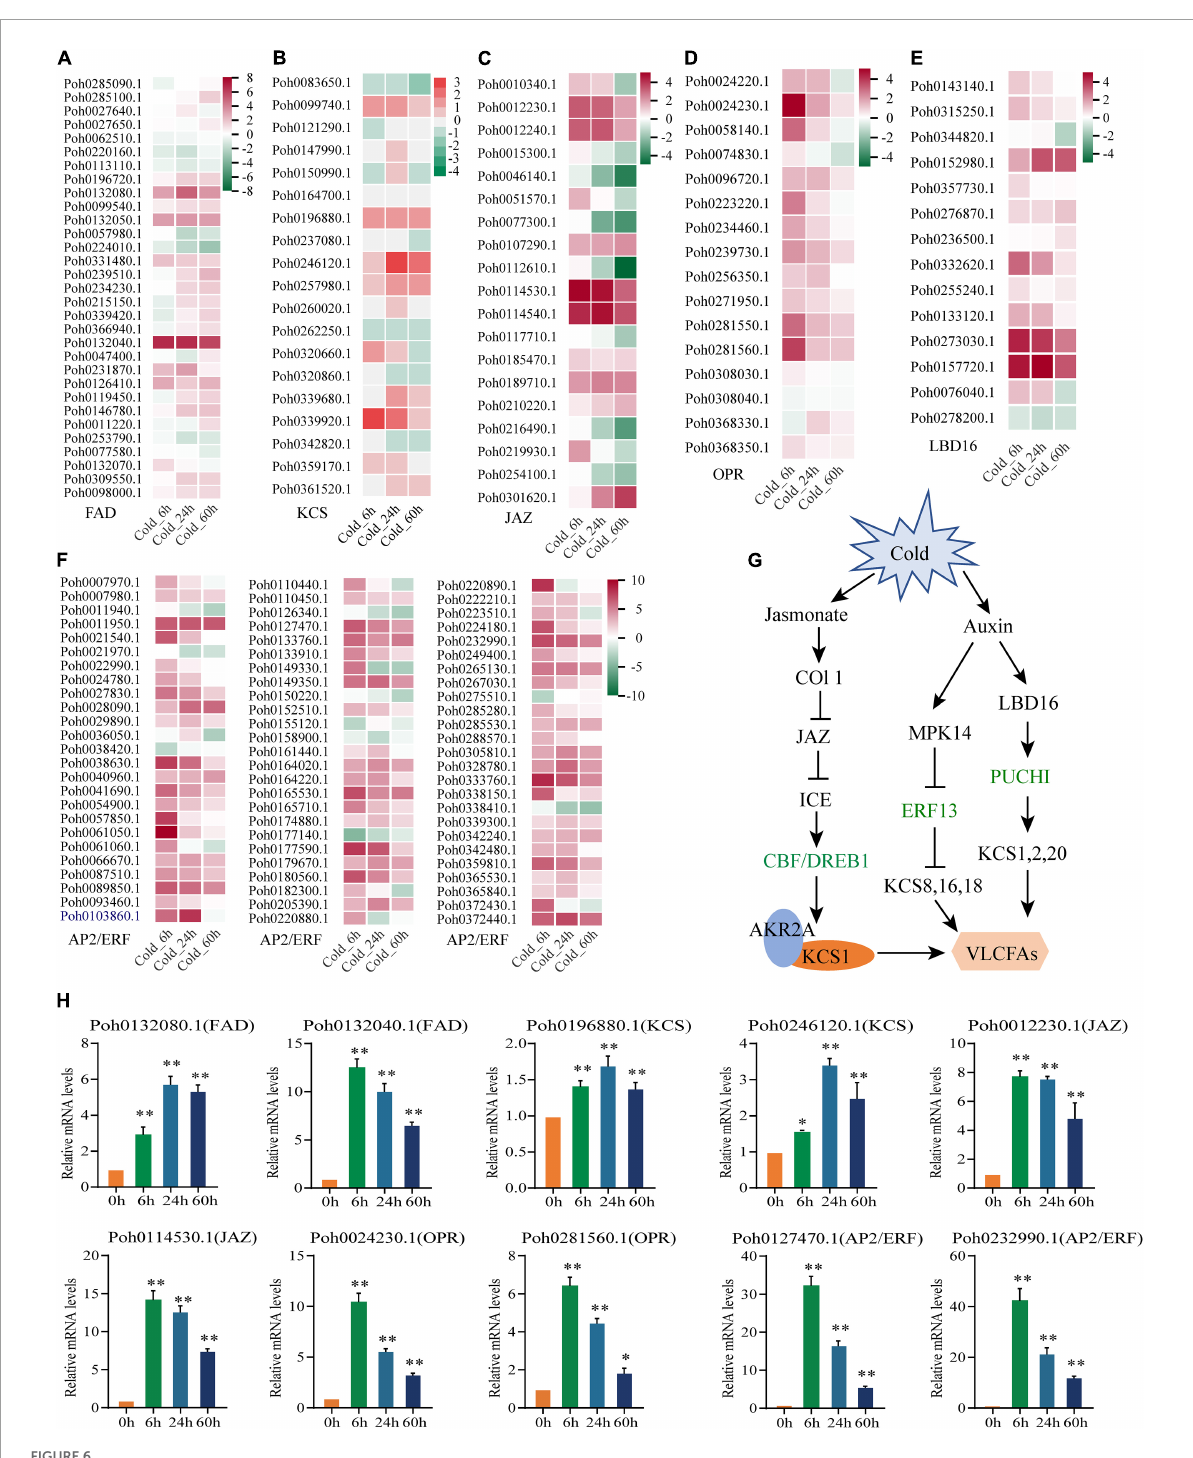
FIGURE6 Genes involved in the biosynthesis pathways of very-long-chain fatty acids were upregulated under cold stress. (A) fatty acid desaturases ( FAD ), (B) β -keto-acyl-CoA synthase ( KCS ), (C) Jasmonate-Zim Domain (JAZ) proteins ( JAZ ), (D) 12-oxophytodienoate reductase ( OPR ), (E) LATERAL ORGAN BORDER DOMAIN 16 ( LBD16 ), and (F) AP2/ERF transcription factor. Heatmaps show the gene expression profile at different time points of cold stress, which were markedly upregulated detected by transcriptome sequencing. As gene expression level increases, the color changes from green (low accumulation) to red (high accumulation). (G) A proposed model summarizing the main pathways for KCS gene expression and very-long-chain fatty acids biosynthesis under cold stress. (H) Several genes involved in the biosynthesis pathway of very-long-chain fatty acids were significantly upregulated under cold stress confirmed by qPCR analysis. Significant difference (* P < 0.05 and ** P <